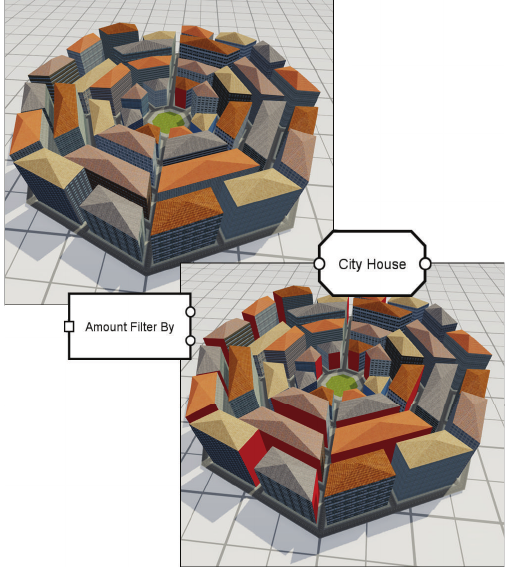
Figure 8: Selection of the main door fac¸ade for several building footprint shapes. Purple arrows indicate a selection by a given fac¸ade index, very common in systems such as [6], which do not always guarantee plausible door locations. All other arrows refer to fac¸ades that are street oriented (as in [12]). From these options, the smallest fac¸ades were chosen using aggregation (yellow and blue arrows), but, to guarantee uniqueness, amount filtering was employed (blue arrows). The selected fac¸ade was fed to the “RayCast” node, which returned the front-facing wall and pointed to the right entity and location for the lot entrance to be built.